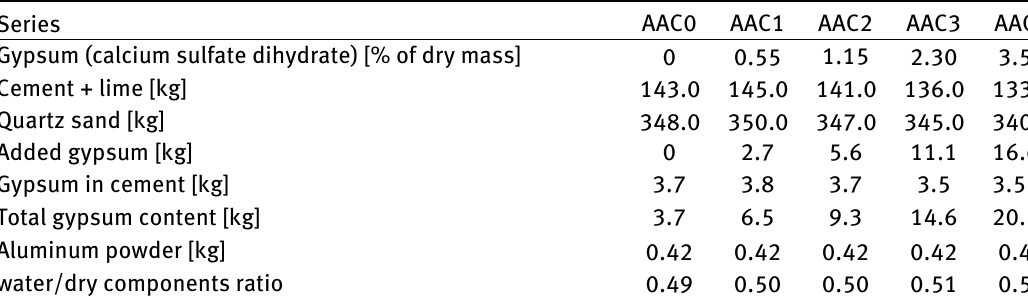
Table 1: Composition of AAC per 1 m 3 of the mixture Series AAC0 Gypsum (calcium sulfate dihydrate) [% of dry mass]